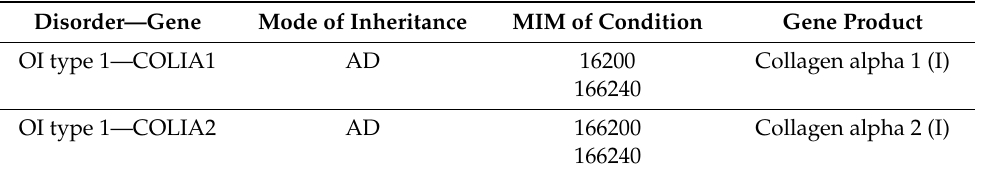
Table 5. Classic Non-deforming OI with Blue Sclerae (OI Type I)–Autosomal dominant (AD), autosomal recessive (AR).